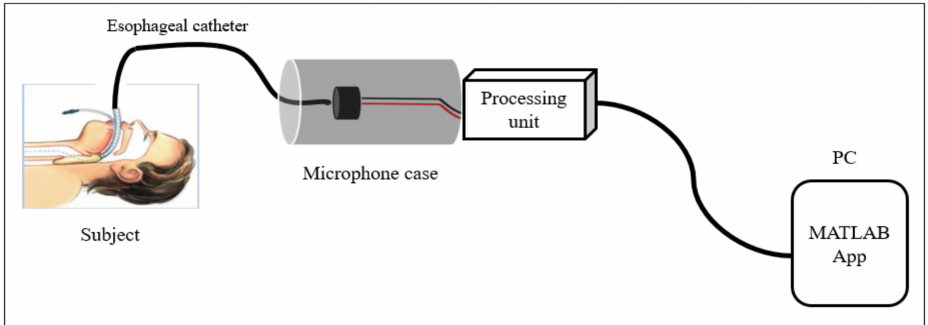
Figure 4. Basic concept of the digital esophageal stethoscope